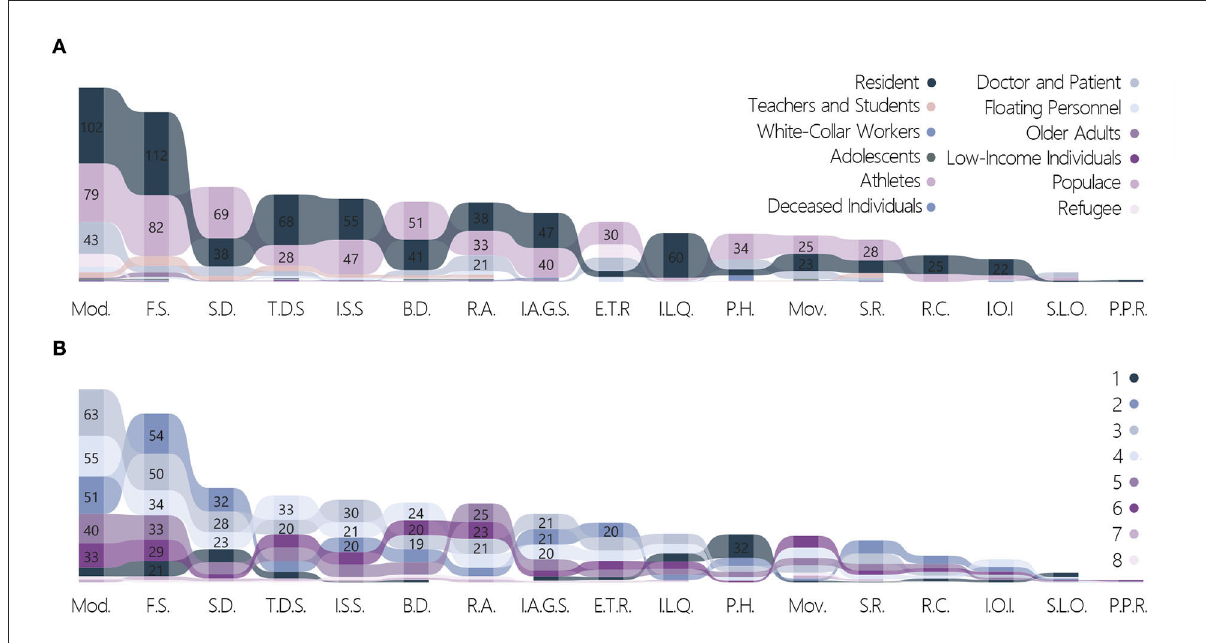
FIGURE12 Cross-tabulation results with target group & quantity of strategies and strategies. (A) Target group and strategies. (B) Quantity of strategies and strategies.